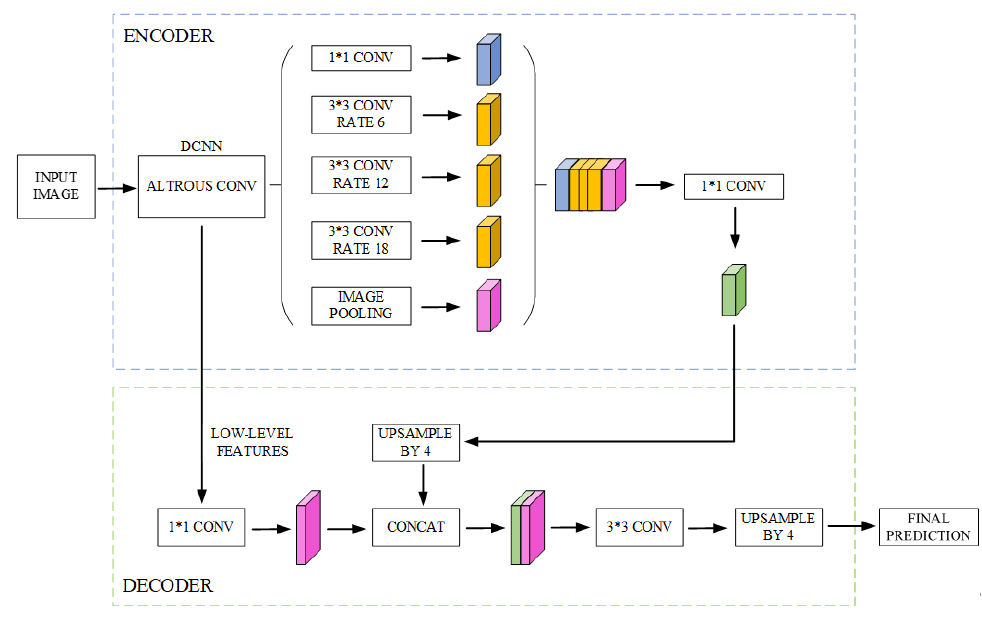
Figure 7. DeepLabV3+ structure.